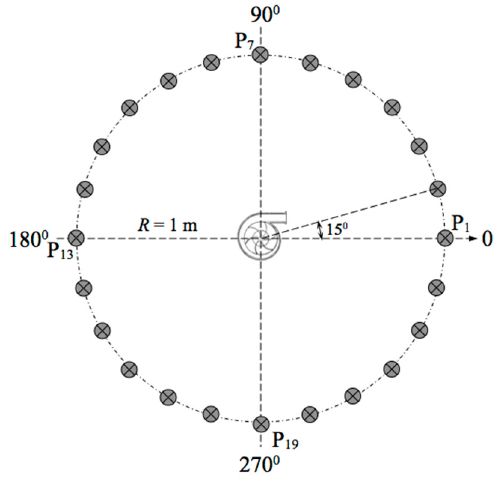
Figure 1. Arrangement of receivers outside the centrifugal pump.